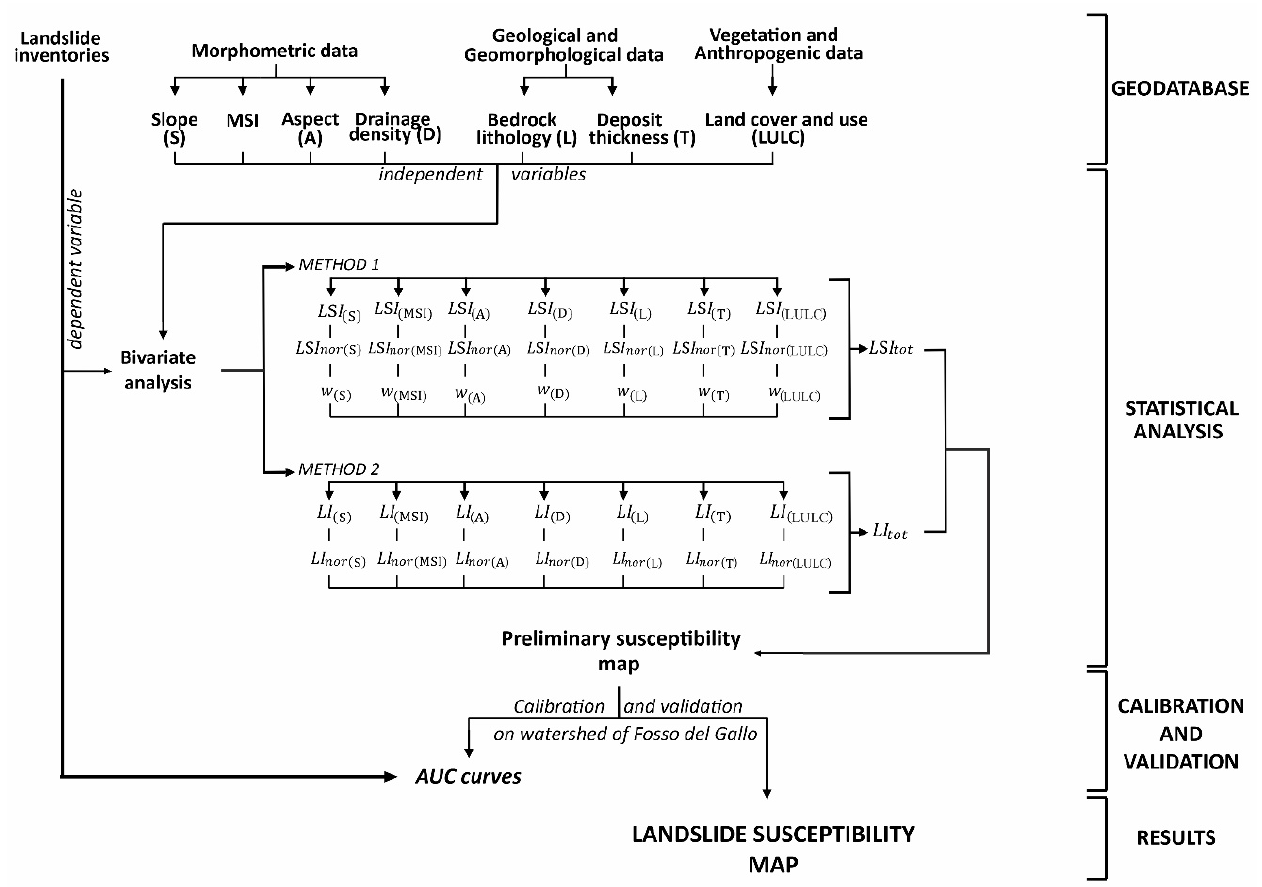
Figure 6. Workflow of the statistical Figure 6. - Workflow of the statistical analysis.